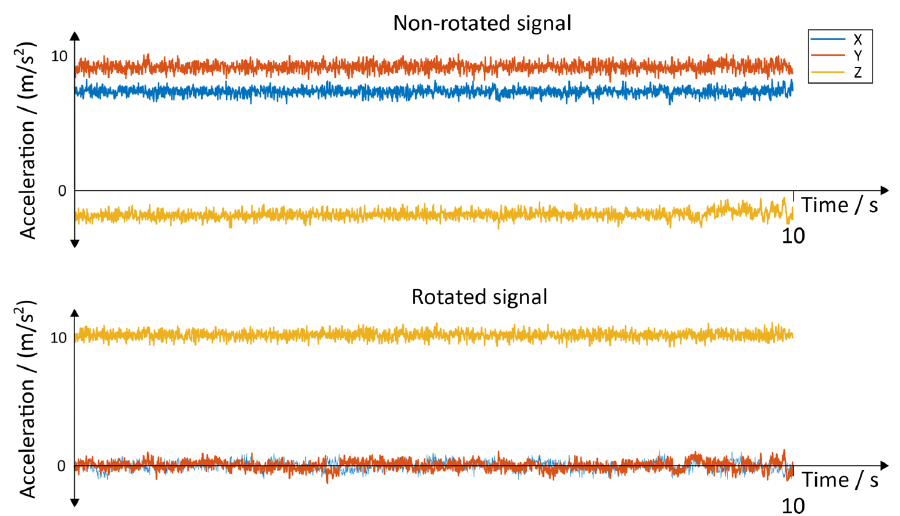
Figure 18. Non-rotated signal and rotated acceleration signals. Position of the sensor: dorsum of the foot.